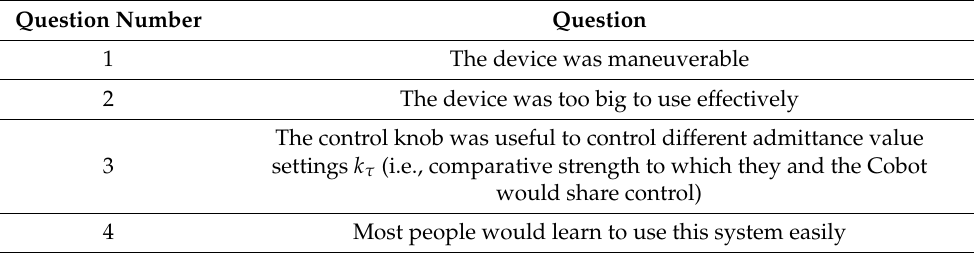
Table 1. List of questions related to usability of the